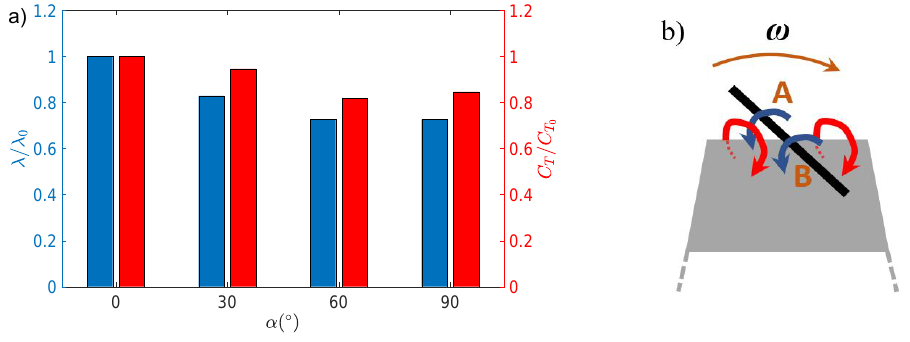
Figure 3. ( a ) comparison of the normalized mean tip speed ratio ( λ / λ o , blue bar) and thrust coefficient ( C T / C T , red bar) of the turbine subjected to various winglet pitch angles; ( b ) schematic of the blade tip o vortices with winglet